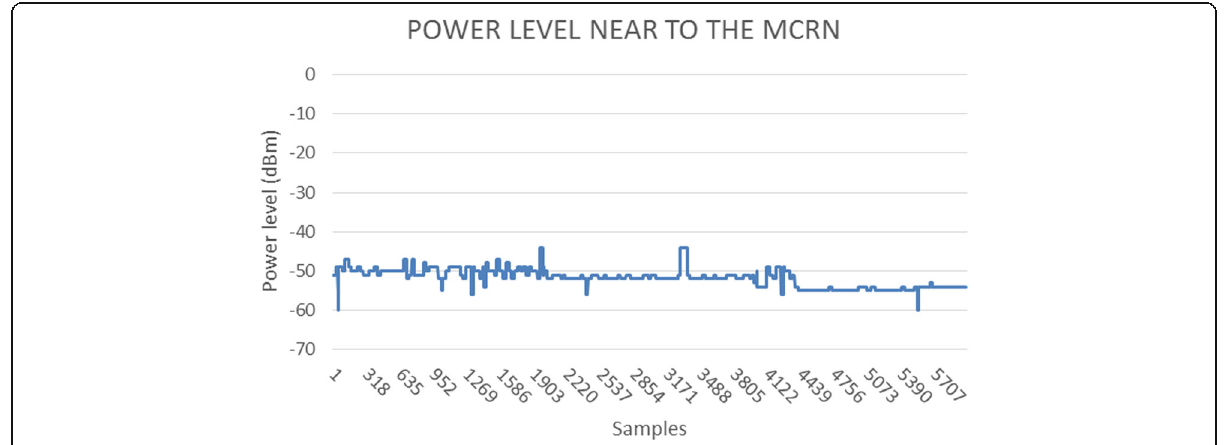
Fig. 11 Power level measured near to the